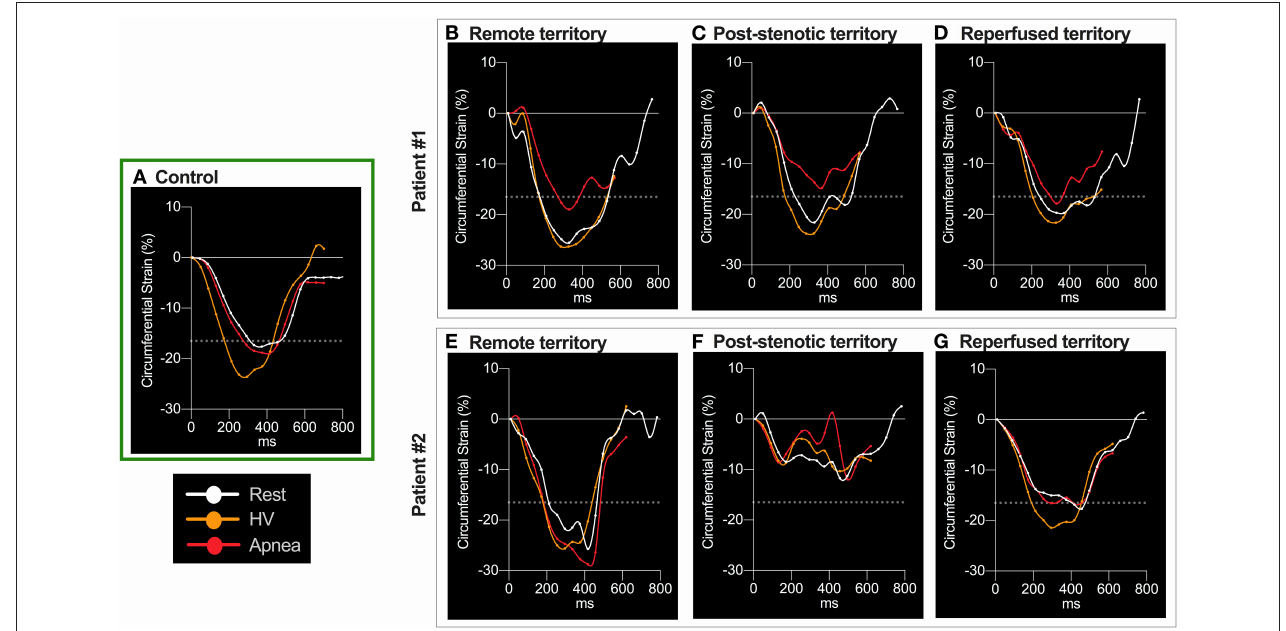
FIGURE 3 | Circumferential strain curve at the different breathing maneuver steps. Circumferential strain during the cardiac cycle for three subjects. In the healthy control participant (A) , hyperventilation (HV, orange) improved peak strain (PS), seen by the more negative values, and shortened time to peak strain (TTP) in comparison to resting conditions (white). Both normalized with apnea (red). The dotted line denotes the level of 1 SD below mean PS of control subjects at rest (-16.5%). Values lower than − 16.5% were regarded as normal peak circumferential shortening in strain. Patient 1: All three territories had normal PS at rest. HV improved PS without altering TTP. In remote myocardium (B) PS was not attenuated beyond − 16.5% and TTP remained unchanged during apnea. In post-stenotic territory regional T1 was 1153ms and T2 was elevated at 45.2ms. Here apnea aggravated PS more severely to a subnormal level (C) and prolonged TTP. The increase in TTP was representative for post-stenotic myocardium in CAD. Reperfused territory experienced stable TTP and less apnea-induced attenuation of PS, still being in the normal range (D) . In the reperfused segments normal native T1 (1120ms) and slightly increased T2 (42.2ms) were found in this patient 33 days after NSTEMI. Patient 2: PS in remote territory remained relatively unaffected by the breathing maneuver (E) . In post-stenotic (F) territories PS was abnormal already at rest and also during provocation. In contrast to the majority of patients, here apnea even provoked severe systolic function in the post-stenotic segments (T1, 1273ms; T2, 35.9ms). In territories reperfused 36 days after an NSTEMI (G) , PS was borderline with no attenuation due to the breathing maneuvers (T1, 1252ms; T2,